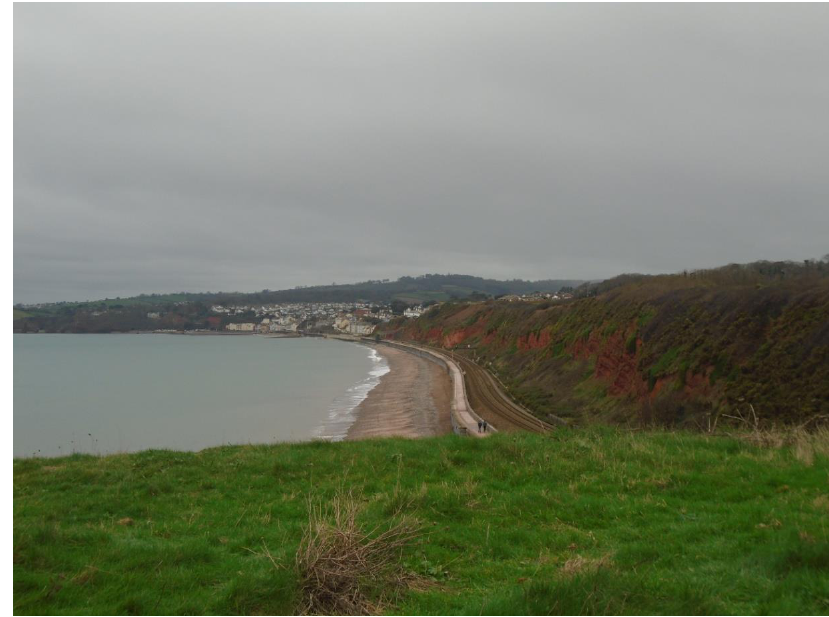
Figure 22. Top of Langstone Point, rail track below.